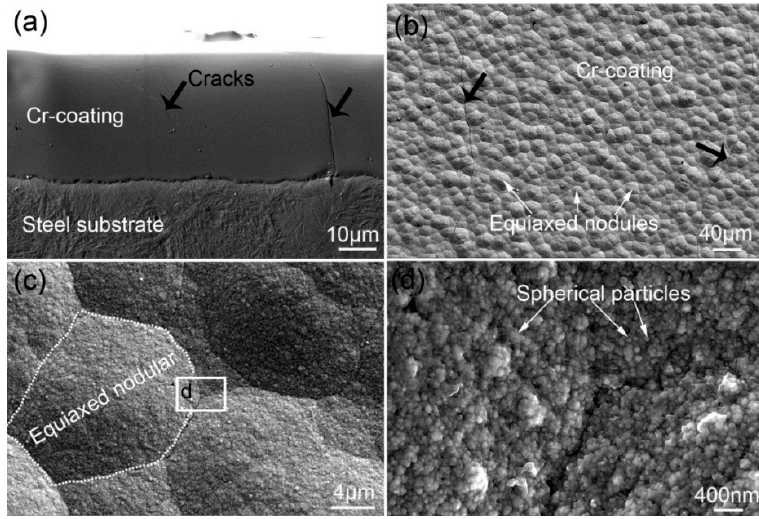
Figure 1. SEI images showing microstructure of the as-plated sample: ( a ) sectional view showing the coating and substrate; ( b ) vertical view showing cracks and equiaxed nodules; ( c ) high-magnification image showing nodule boundaries; ( d ) enlarged image of white box in ( c ).